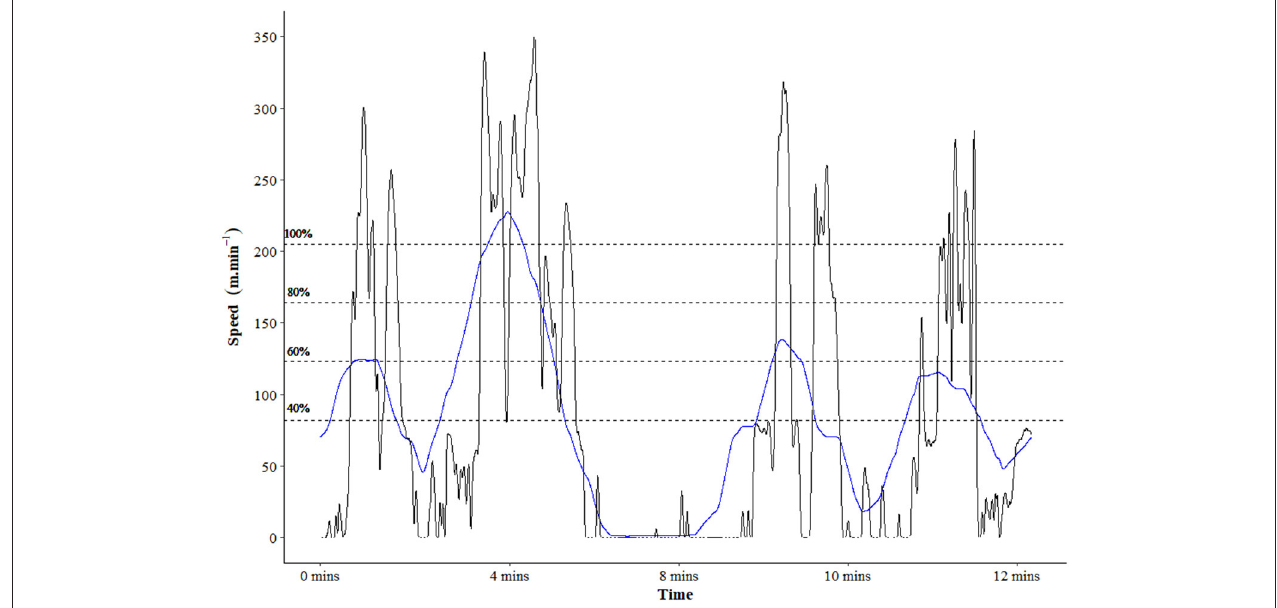
FIGURE 1 | Example 1-min moving average of speed (blue line) and raw speed (black line) across a training game, demonstrating the fluctuating intensity and the purpose of this moving average method. The dotted lines represent values relative to the maximal mean (205 m · min − 1 ) at 20% increments. NB. This file represents one athlete’s match file, and in this match could reach speed above the reported maximal mean of 205 m · min − 1 that is obtained from the squad.